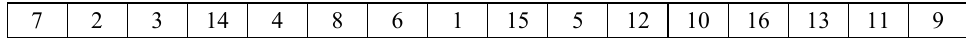
Fig. 3. The encoded solution for the layout shown in Fig.